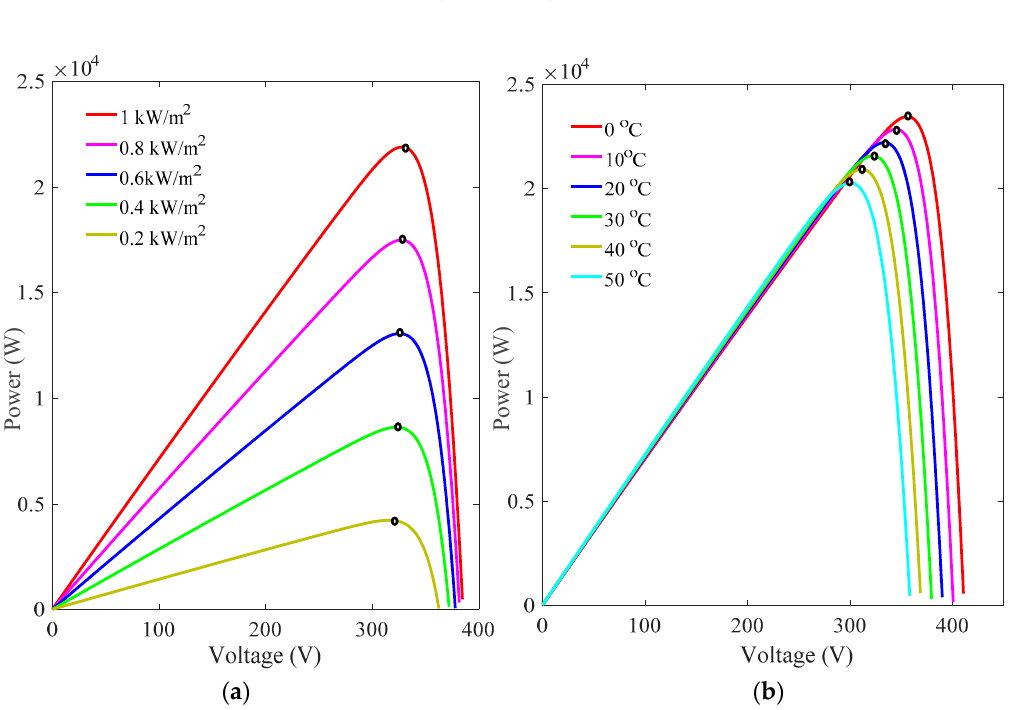
Figure 4. PV power characteristics: ( a ) The power characteristics of the entire analyzed PV array for different solar irradiation; ( b ) The power characteristics of the entire analyzed PV array for different temperature.